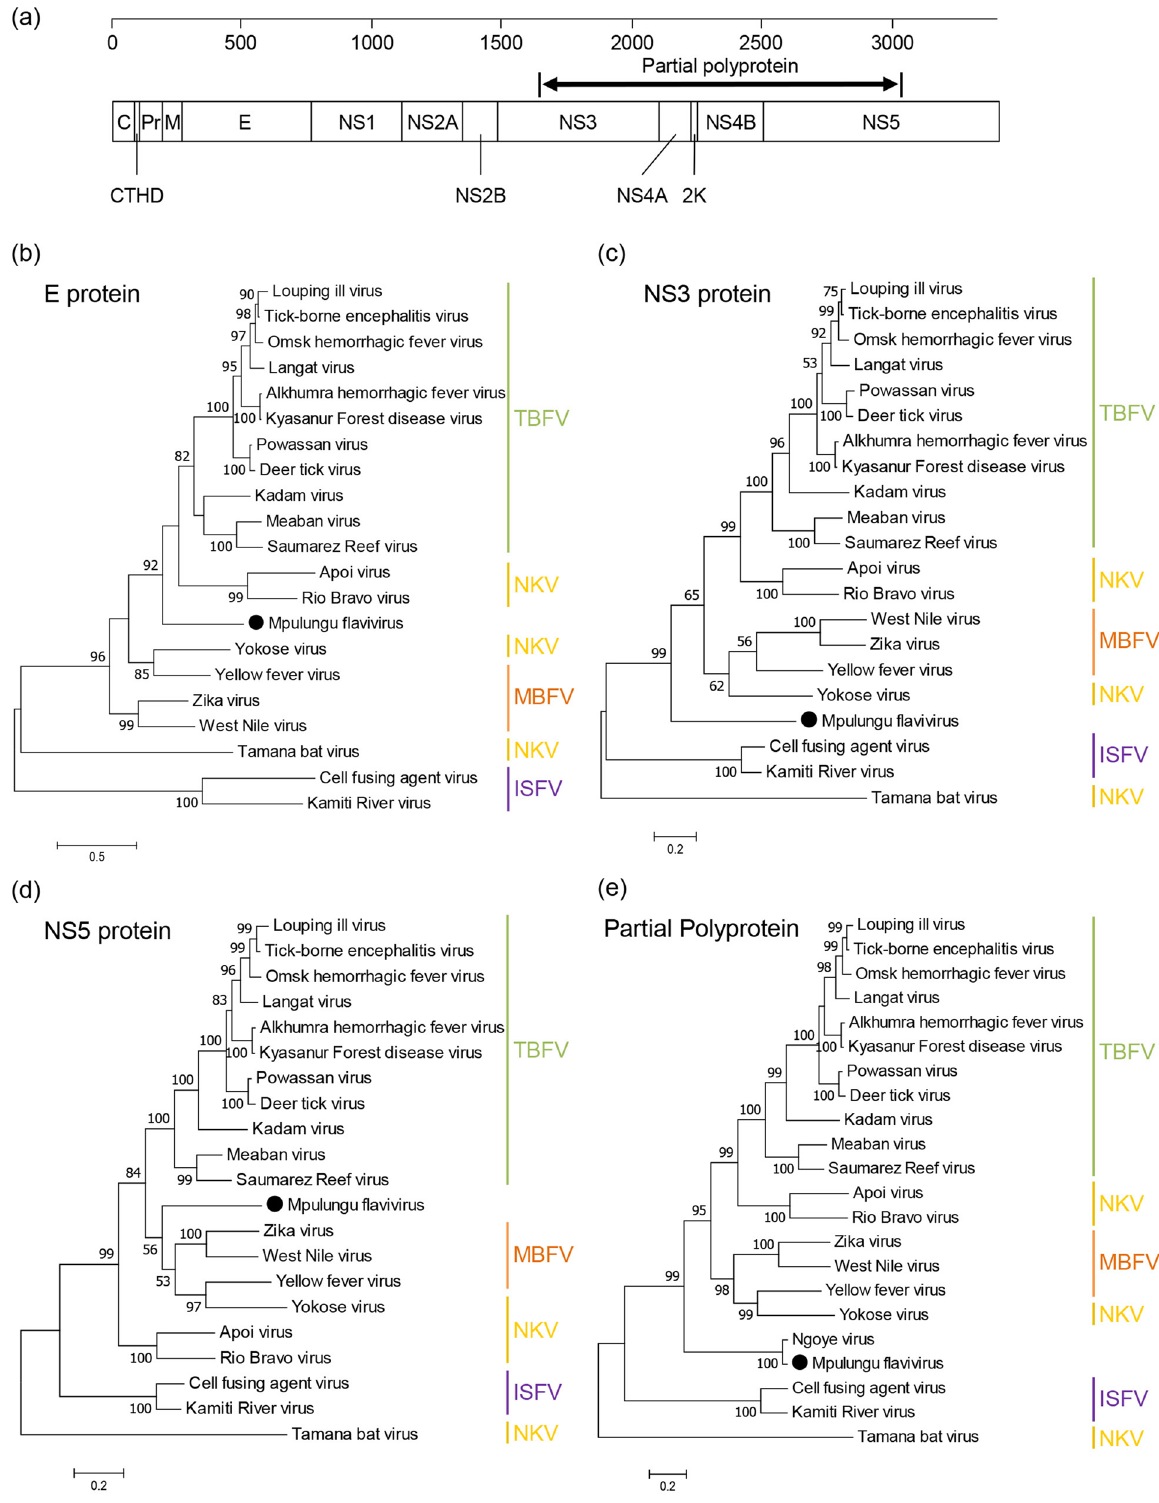
Figure 3. Phylogenetic analyses of E, NS3, NS5 and partial polyprotein. ( a ) Schematic diagram of MPFV polyprotein. A black double-headed arrow represents the sequenced region of Ngoye virus. Trees were constructed using the maximum-likelihood method with 1000 bootstrap replications as based upon 427–509 amino acid sequences for E ( b ), 577–623 amino acid sequences for NS3 ( c ), 855–906 amino acid sequences for NS5 ( d ), and 1392 amino acid sequences from the polyprotein corresponding to positions 1642–3033 of MPFV polyprotein ( e ). Bootstrap values > 50% based on 1000 replications are shown on the interior branch nodes, and the scale bar indicates the number of substitutions per site. Group names are indicated on the